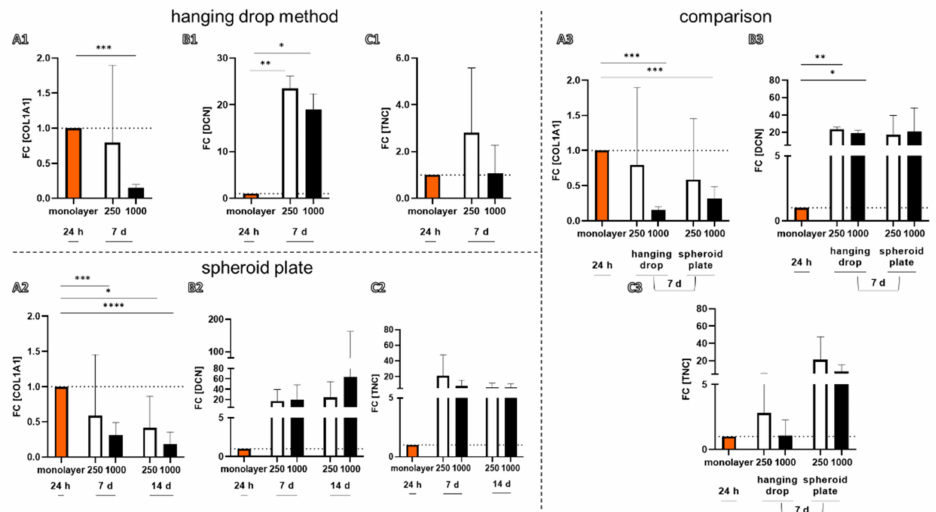
Figure 5. Gene expression in spheroids prepared in hanging drops or using the spheroid plate in comparison to that in monolayer culture. ( A ) Collagen type 1 (COL1A1), ( B ) decorin (DCN), ( C ) tenascin C (TNC). ( A1 –C 1 ) Gene expression of ligamentocyte spheroids prepared by the hanging drop method after 7 days. ( A2 – C2 ) Gene expression after 7 and 14 days in spheroids prepared with the spheroid plate. ( A3 – C3 ) Direct comparison of the gene expression in spheroids prepared by both methods after 7 days. Statistics: n = 5 independent experiments were performed with cells of five different donors. One-way ANOVA (Tukey’s multiple comparisons test) for comparison between groups. Grubbs test ( α = 0.05). p values: * < 0.05, ** < 0.01, *** < 0.001, **** < 0.0001 ( A1 – C3